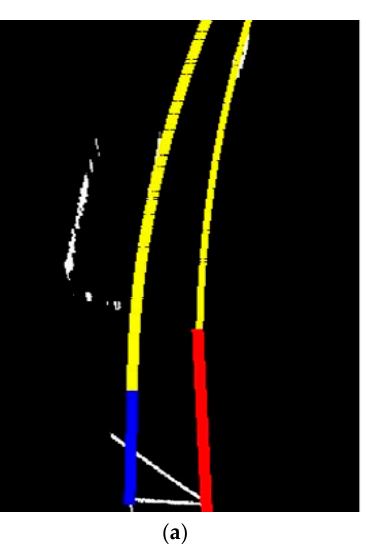
Figure 26. Comparison between measured value (blue), KF estimation (Orange), and true value (Red) of circle detection.